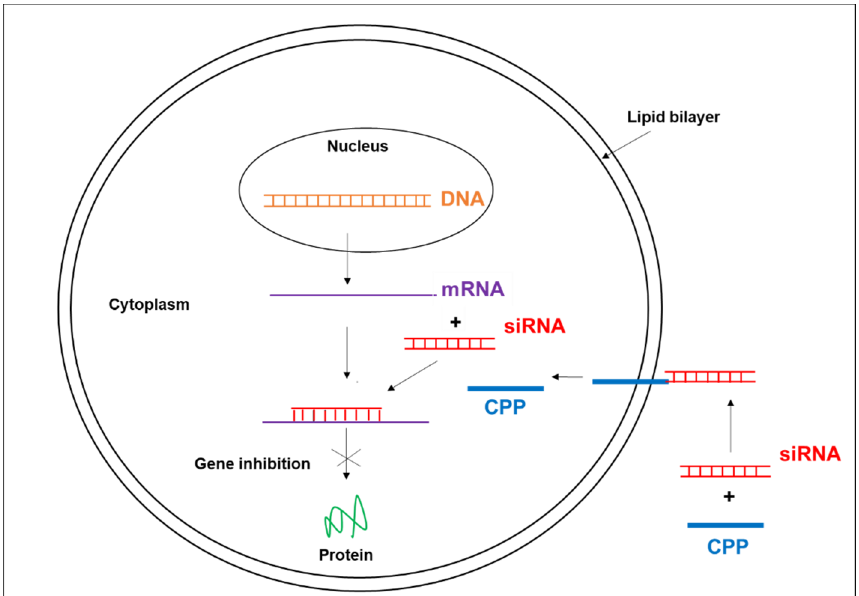
Figure 2. The CPP, a nonviral gene delivery system, favors intracellular uptake of small interfering RNA (siRNA) and induces gene inhibition.